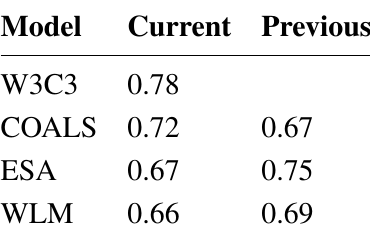
Table 3. Current and previous correlations with